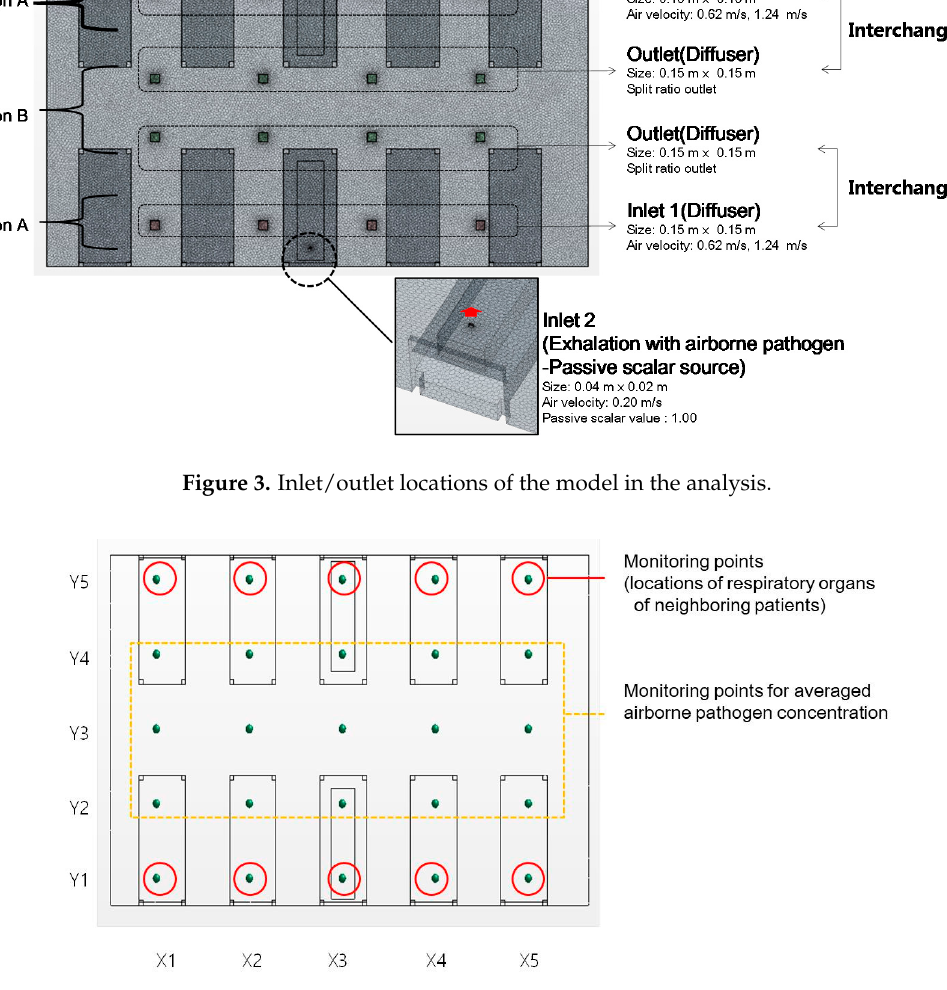
Figure 4. Monitoring points for the concentrations of the airborne pathogen.